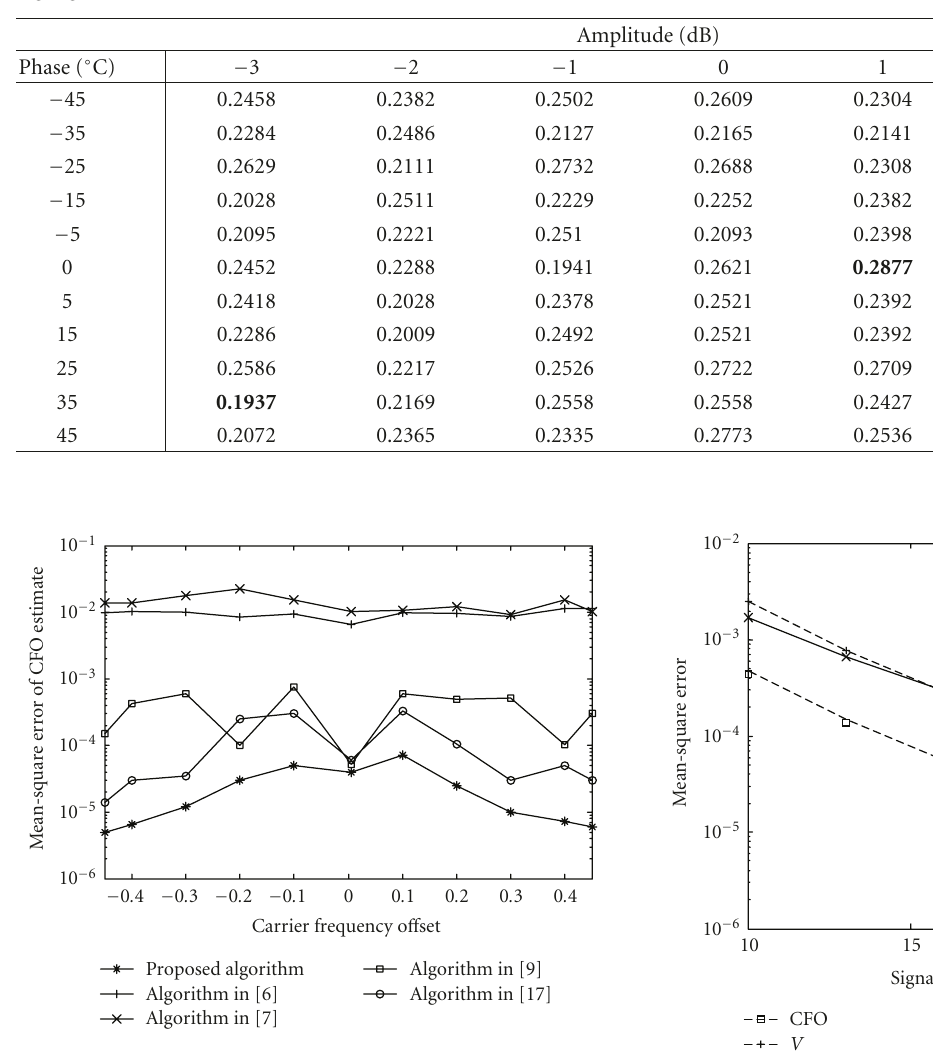
Figure 5: MSE comparison of CFO estimation algorithms with heavy I/Q imbalance ( g = 1dB and θ = 15 ◦ ).